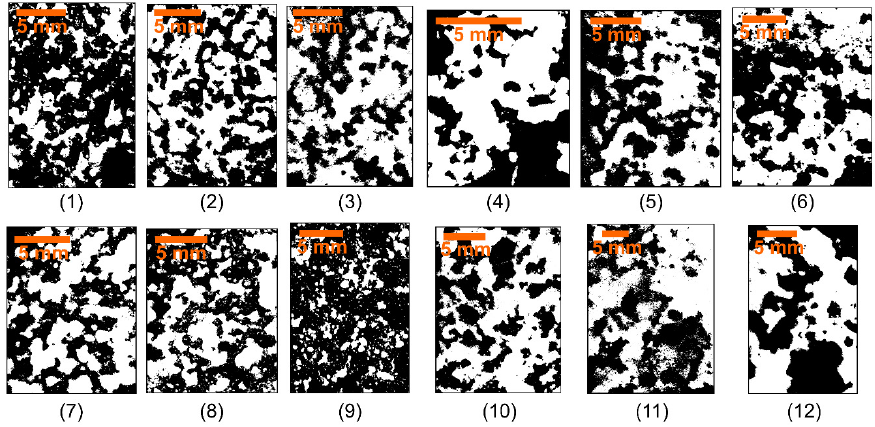
Figure 8. Typical binary images for different